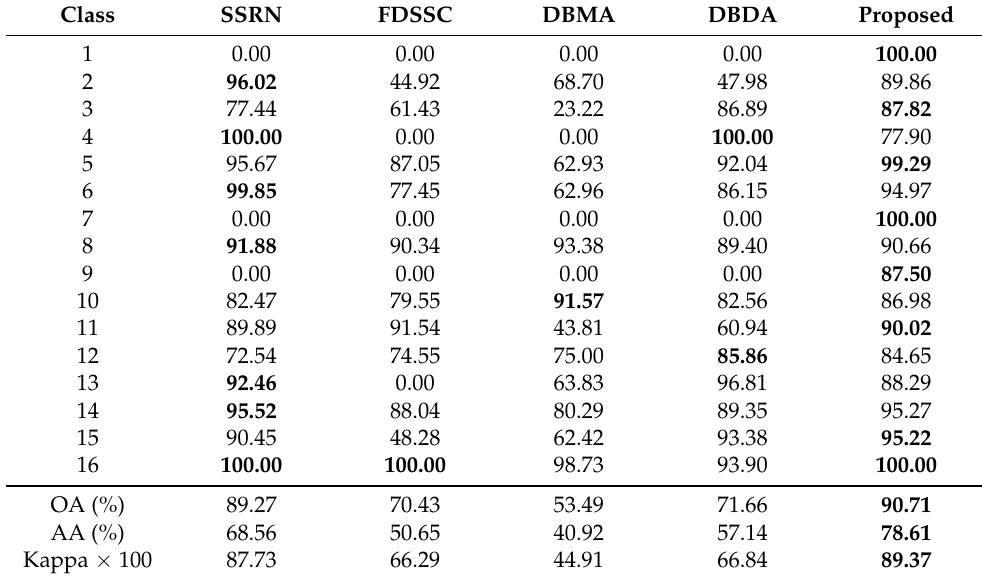
Table 6. Categorized results for the IP